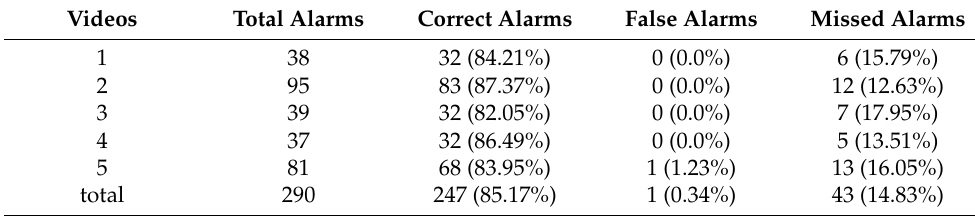
Figure 12. Some screenshots of ( a – c ) VS videos and ( d – f ) IR videos. Detected moving objects (people) are labeled. Table 5. Statistics of monitoring results of VS videos.